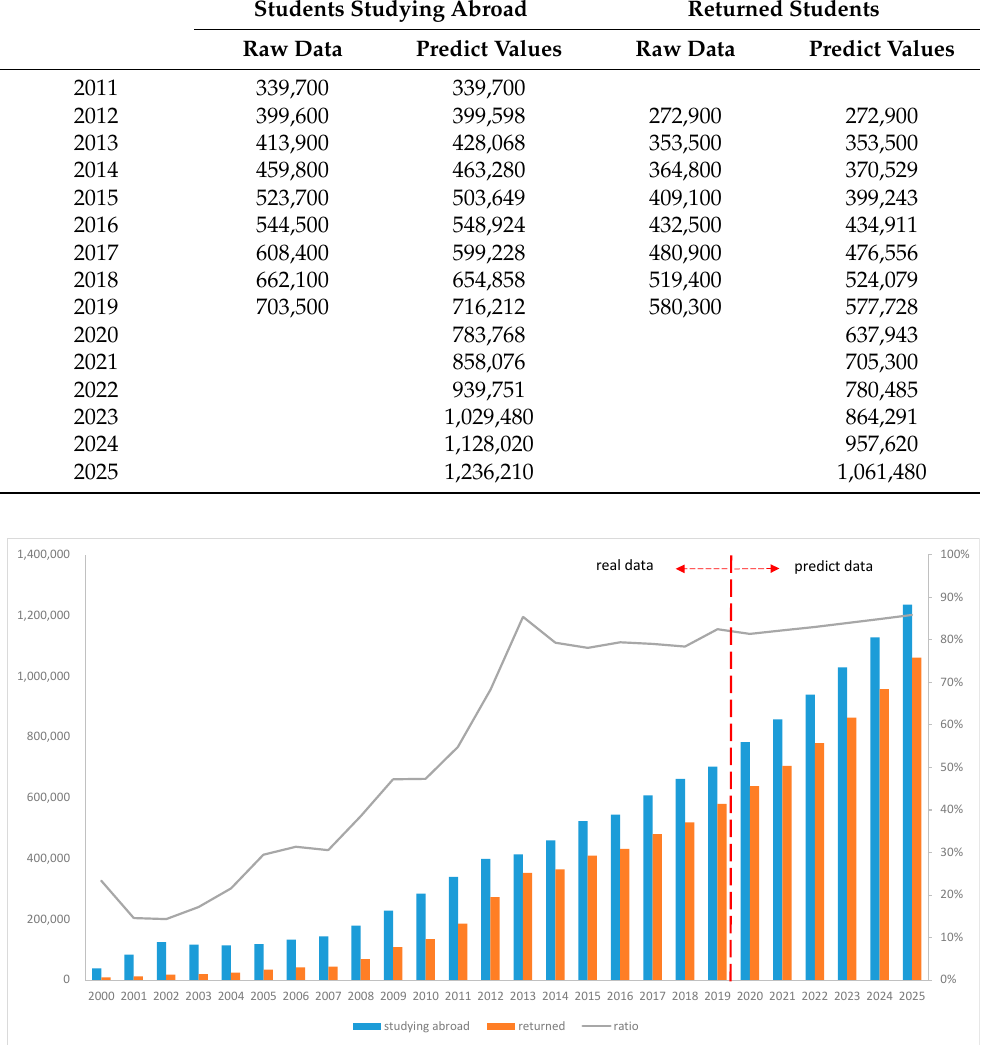
Figure 6. Ratio of returned students to students studying abroad.